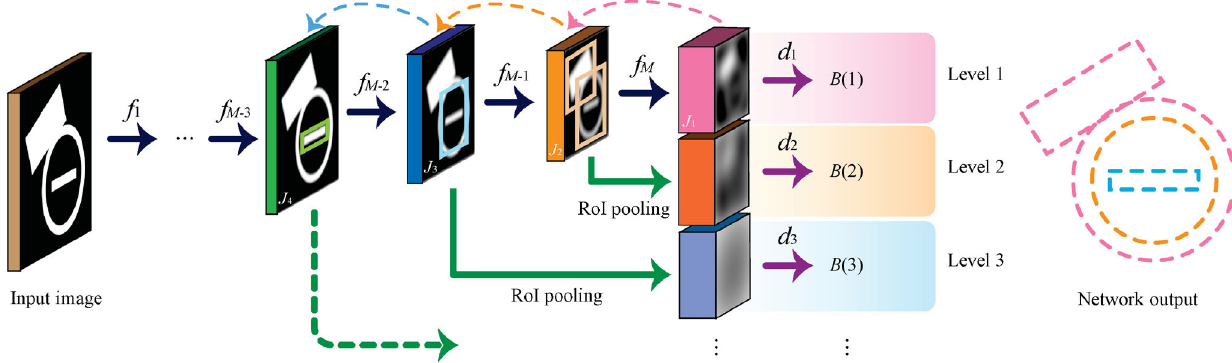
Fig. 2 The detection process in our layered model. Cuboids denote input images or feature maps. Dark blue arrows, dark green arrows, and dark purple arrows represent conv layers, RoI pooling layers, and detection blocks, respectively; notation is consistent with that in the text. The final output of our network is a layered primitive tree containing both shape information and layer